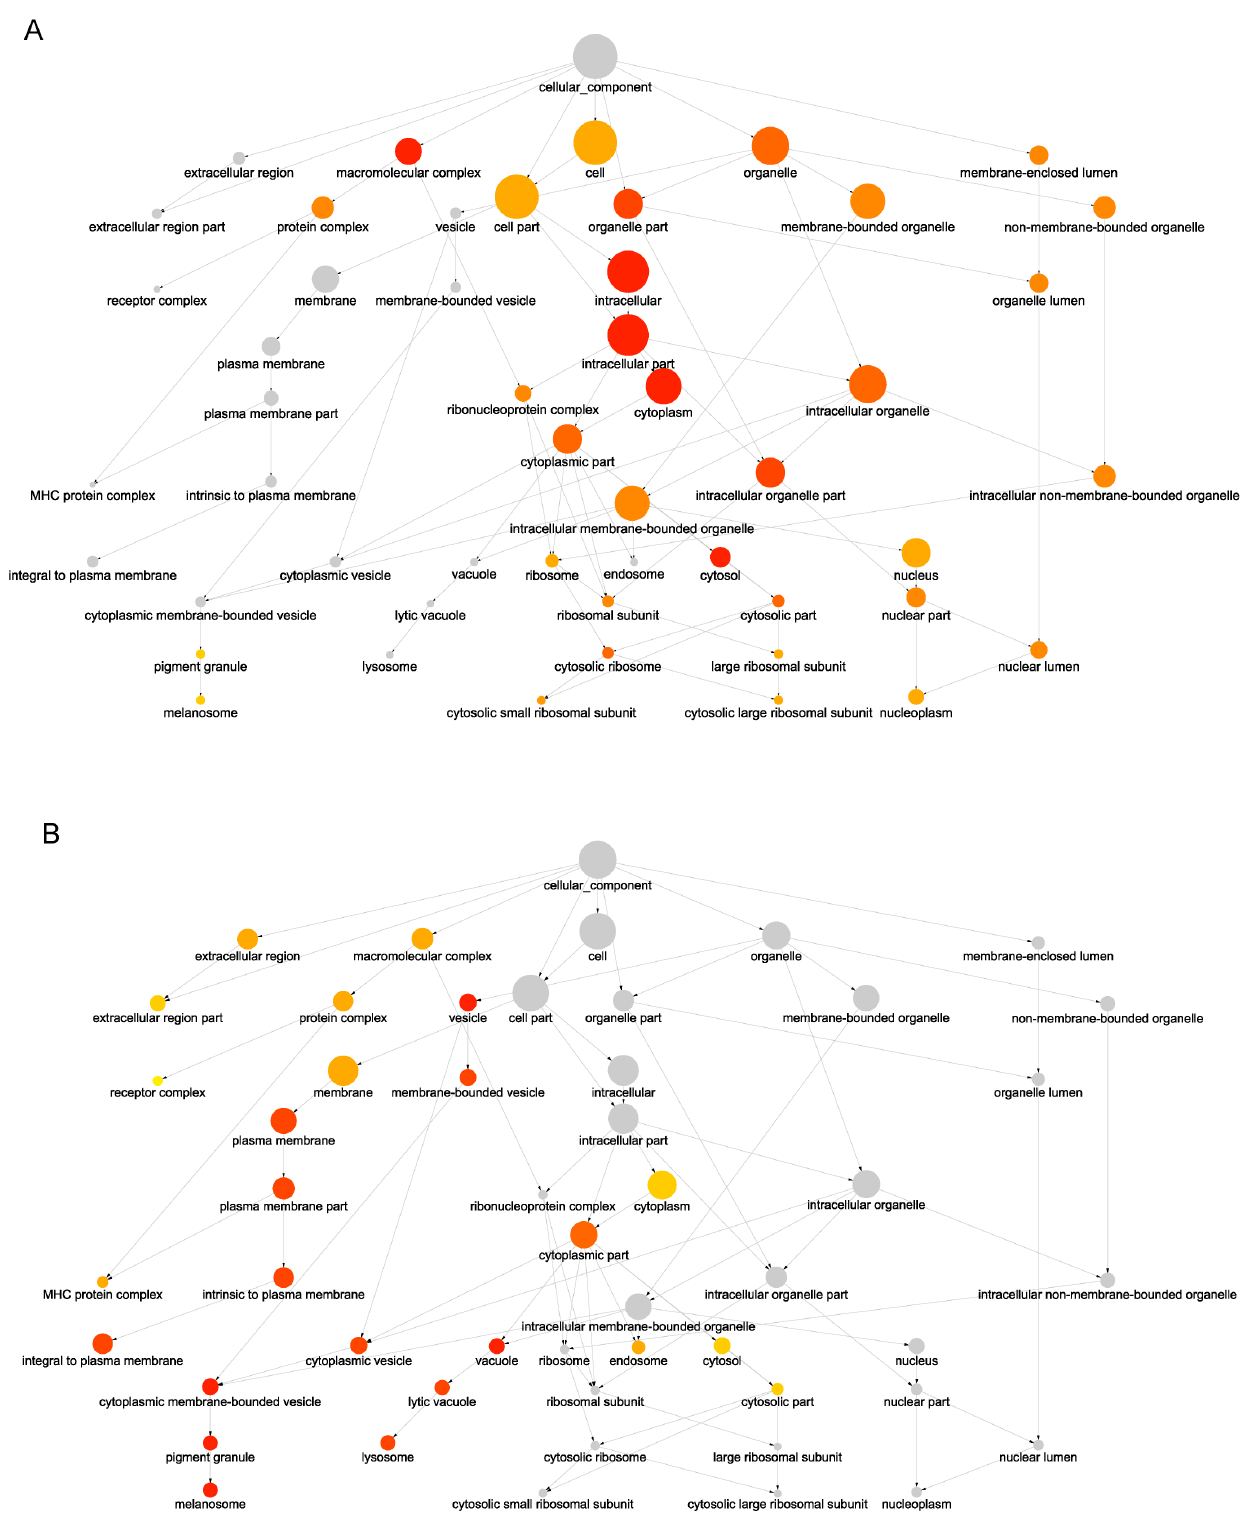
Figure 1. Overview of GO cellular component terms enriched among proteins containing MHC ligands. The results from an enrichment analysis were superimposed onto the GO tree structure; A: MHC class I ligand-containing proteins (MHCI data set) B: MHC class II ligand-containing proteins (MHCII data set). Only nodes representing the most significant terms are included (p-value cut-offs used as inclusion criteria is 1.00*10 2 13 for the MHCI data set and 0.01 for the MHCII data set). The significance level is reflected by the node colour, where red corresponds to the most significant p-values while grey indicates no enrichment. The size of the nodes reflects the number of proteins assigned to this term.